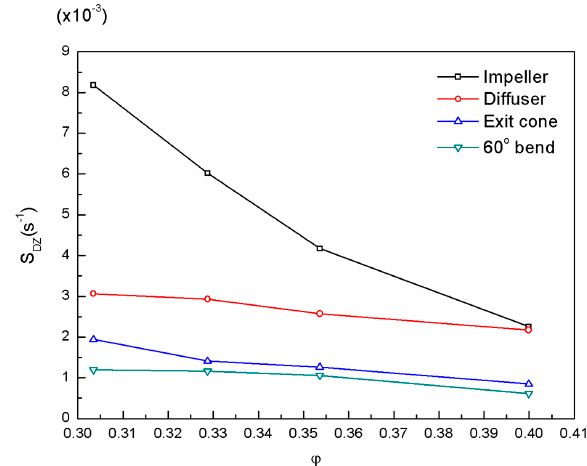
Figure 8. Percentage contributions of the overall turbulent entropy generation rate 𝑆(cid:4662) (cid:3005) (cid:4594) of a component to the overall entropy generation rate for the same component with four discharges.